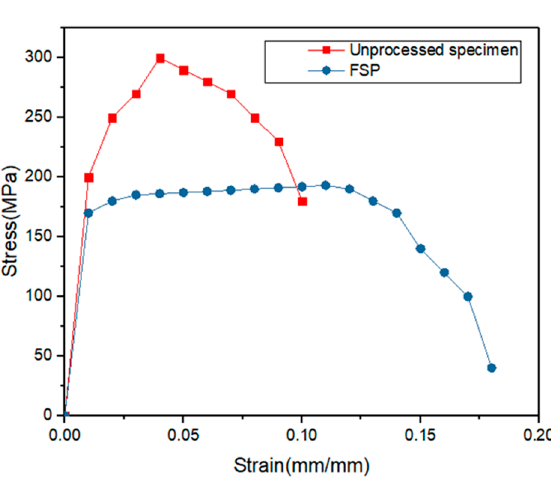
Figure 2. Tensile stress and strain curves for processed and unprocessed surface.